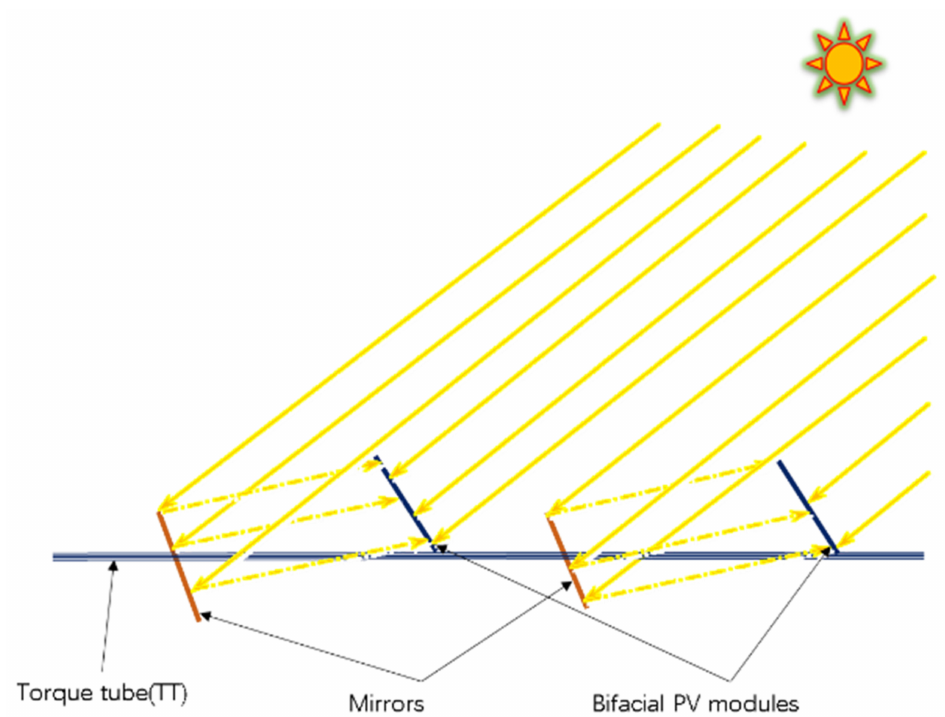
Figure 1. The principle of the bifacial companion method for light supplementation and efficiency enhancement of tilted bifacial modules with horizontal single-axis trackers.